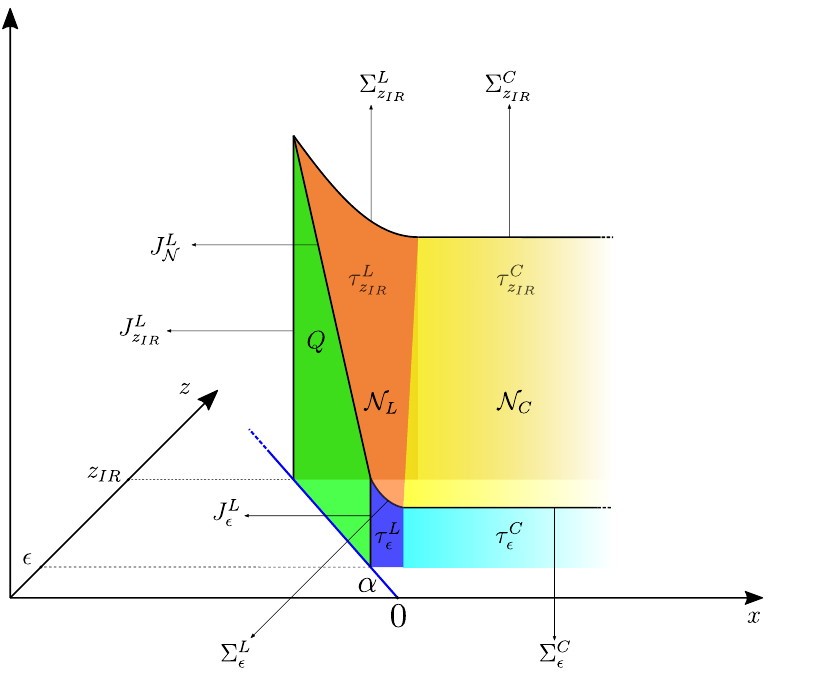
Figure 2 . The future half of the regularized WDW patch for AdS 3 with a